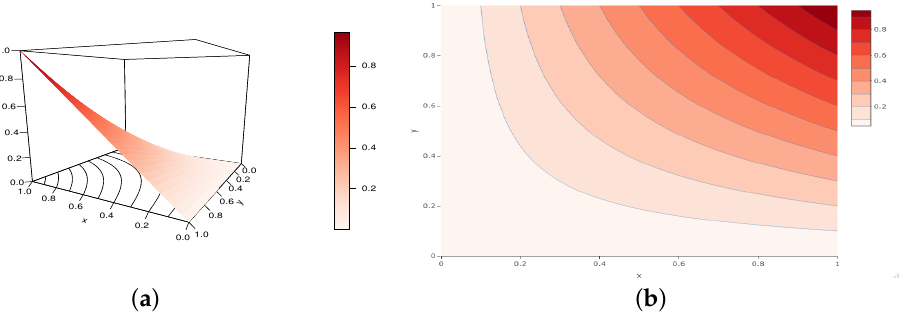
Figure 11. Illustrations of the ( a ) perspective plot and ( b ) contour plot of the TGCC copula for the following configuration: a = 1/4 and b = c = 2, belonging to Configuration 1.